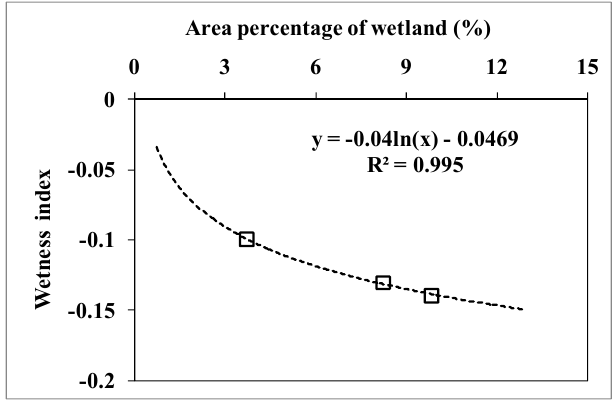
Figure 7. Wetness index versus area percentage of beaches.